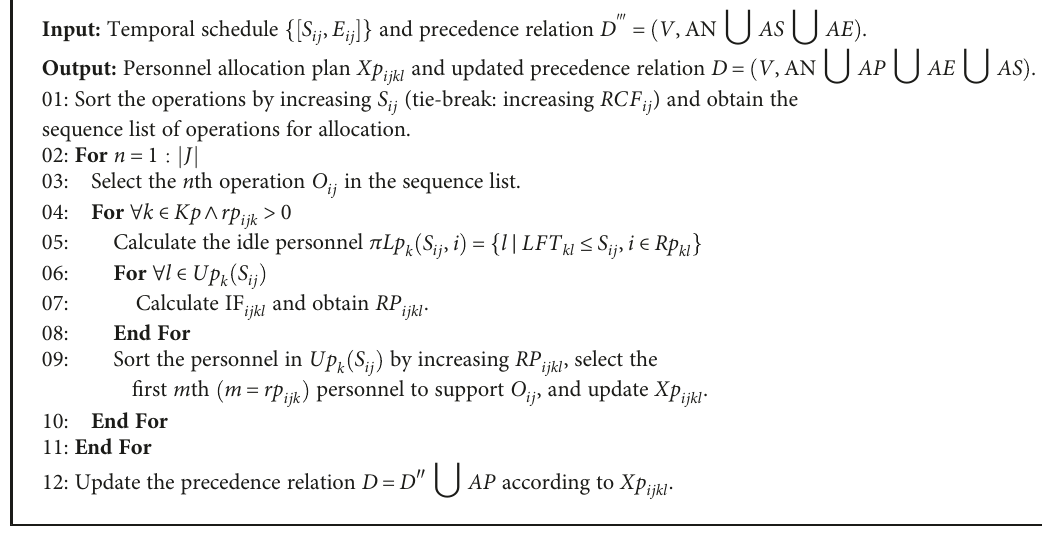
Algorithm 4: Robust personnel allocation